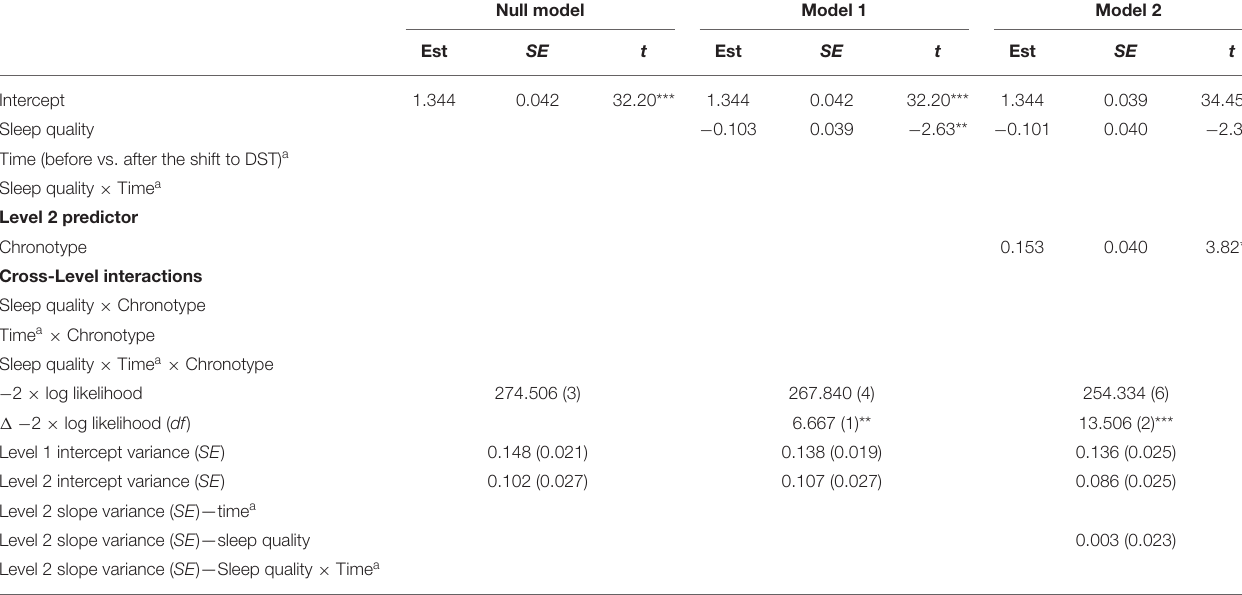
TABLE 2 | Results of multilevel analyses predicting day-specific